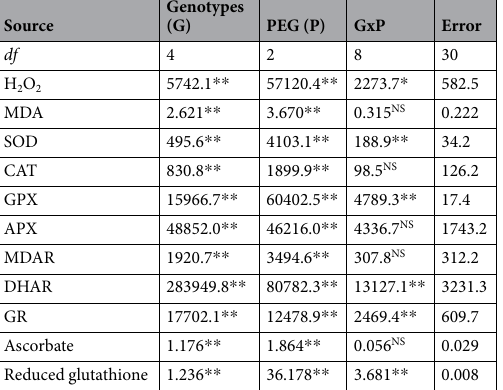
Table 2. Two way analysis of variance for biochemical estimations and ROS scavenging antioxidants of Chinese potato genotypes under in vitro PEG mediated osmotic stress conditions in a 5 × 3 factorial experiment in